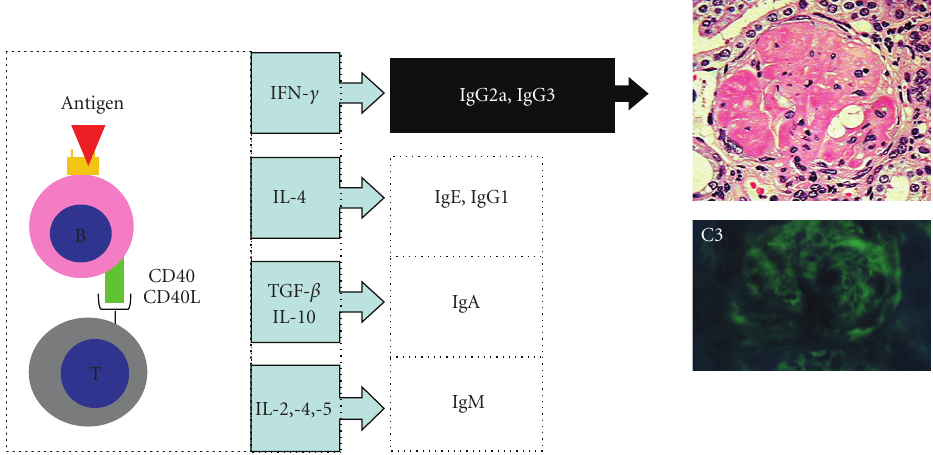
Figure 1: Class-switcing of immunoglobulin. Cognate contact of T-B interaction and following stimulation of cytokines determine Ig subclass switching in